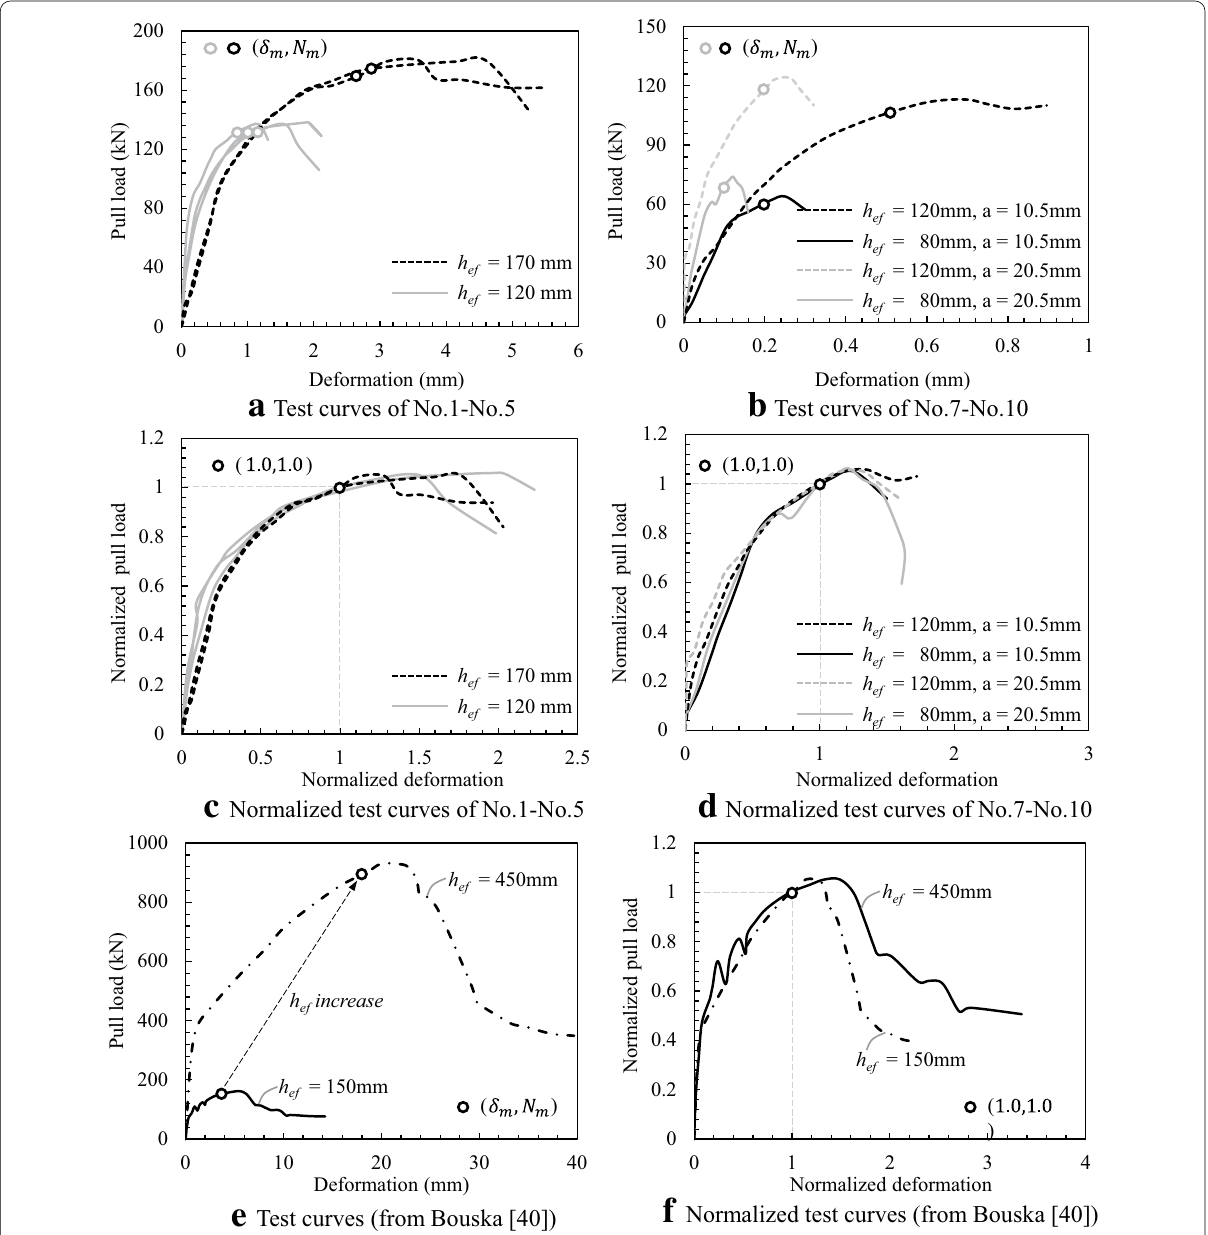
Fig. 9 Load–deformation curves of the anchorage concrete with different embedment